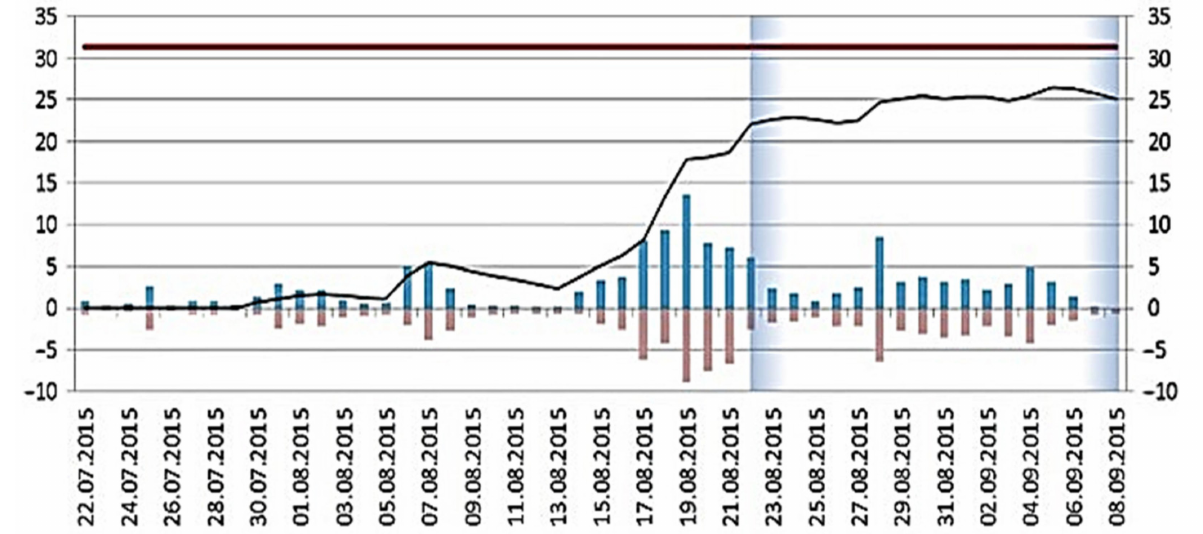
Figure 2. Water balance estimation for the example of the 2015 Assam flood. Blue bars refer to the whole volume of daily precipitation in the whole basin (summarized through regions), in units 10 9 m 3 ; red bars–the whole volume of daily evaporation + permeation in the whole basin (summarized throughout the region), 10 9 m 3 ; black line–the whole volume of accumulated water mass in the whole basin (summarized through regions), 10 9 m 3 ; red line–the maximum of observed water mass, 10 9 m 3 . On the vertical axis–the water level (10 9 m 3 ). On the horizontal axis–measurement days (date). All detailed databases on the subject can be introduced by event analysis using